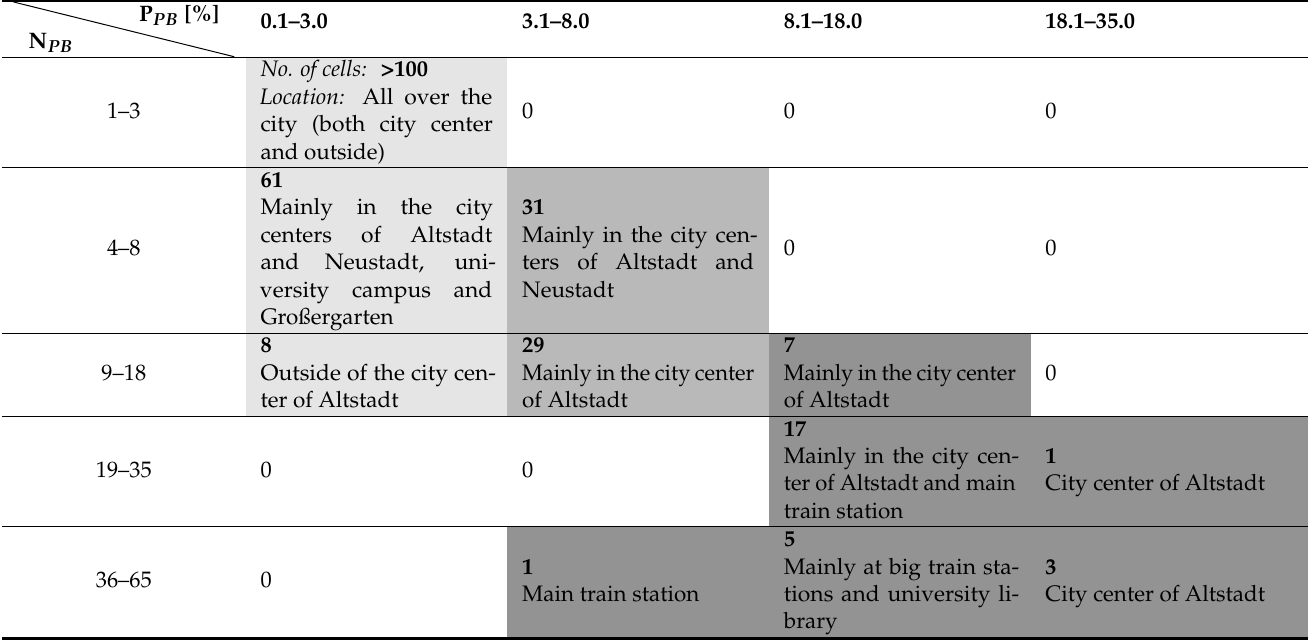
Table 3. Number and common urban location of 100 × 100 m grid cells in Dresden for each combination of the photos in the dataset containing stationary bicycles P PB and the number of stationary bicycle detections on photos N PB . Shades of gray refer to relevances assigned in Table 2. N